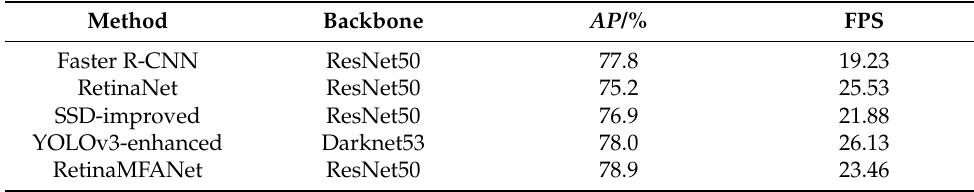
Table 3. Algorithm performance comparison table.